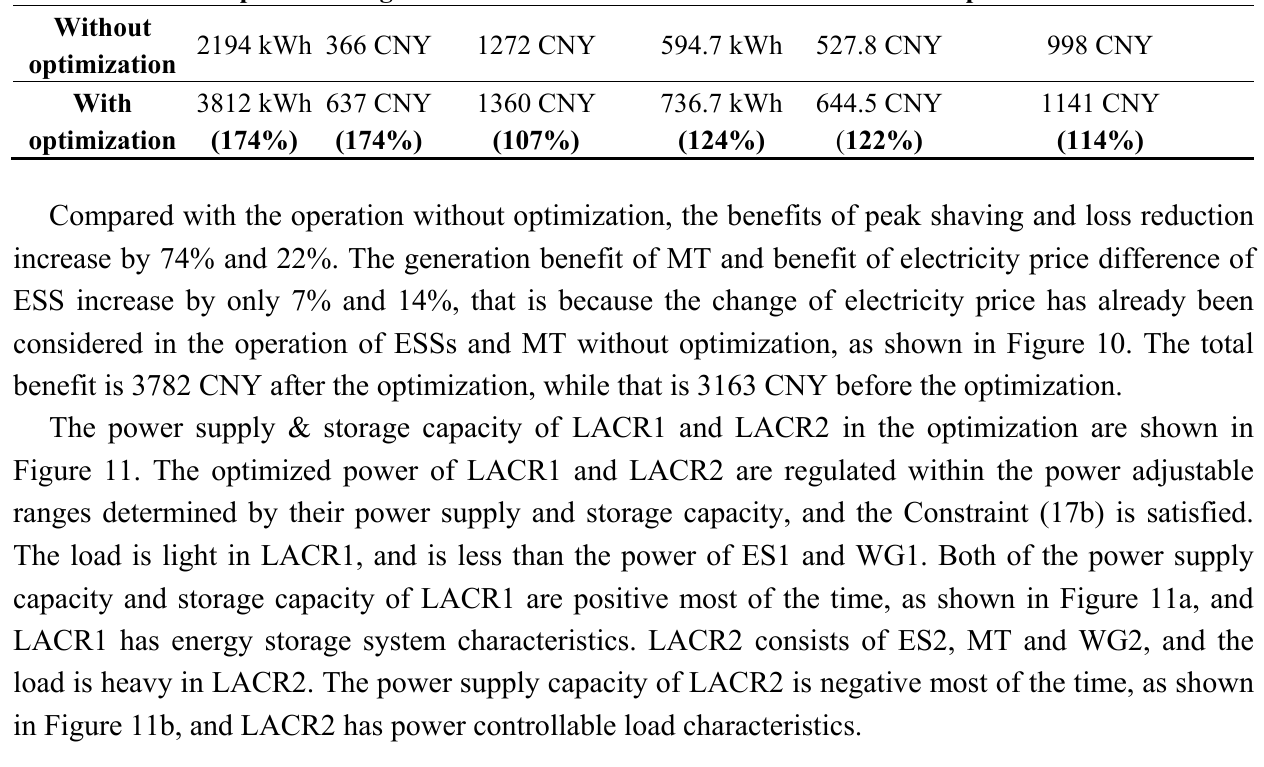
Figure 11. ( a ) Power supply and storage capacity and actual power of LACR1; ( b ) Power supply & storage capacity and actual power of